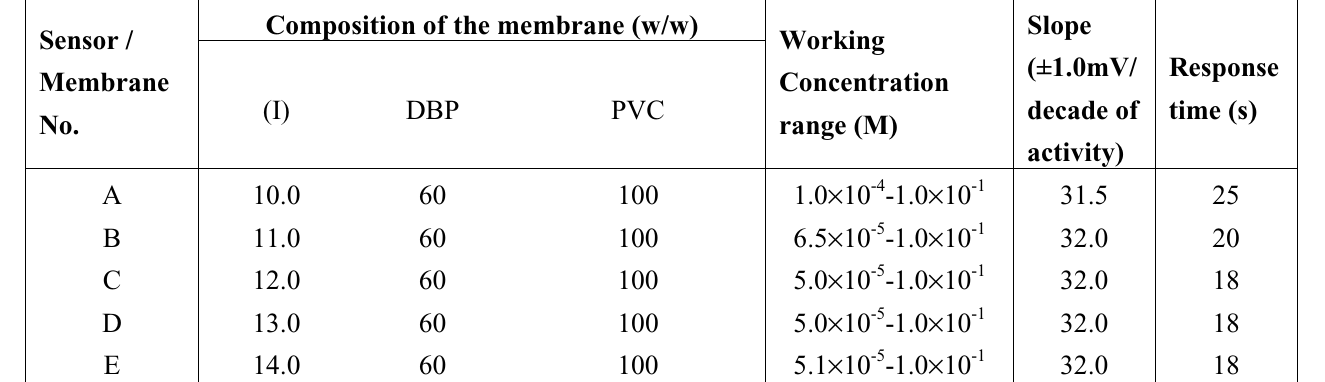
Figure 1. V ariation of membrane potential of PVC based membranes of ( I ) with varying concentrations of MoO 42- ions (1) without plasticizer (2) with DBP (3) with DOP (4) with TBP (5) with CN and (6) with DBBP, respectively. Table 2. Response characteristics of PVC based membranes having different amounts of TMOPP-Co(I) as active